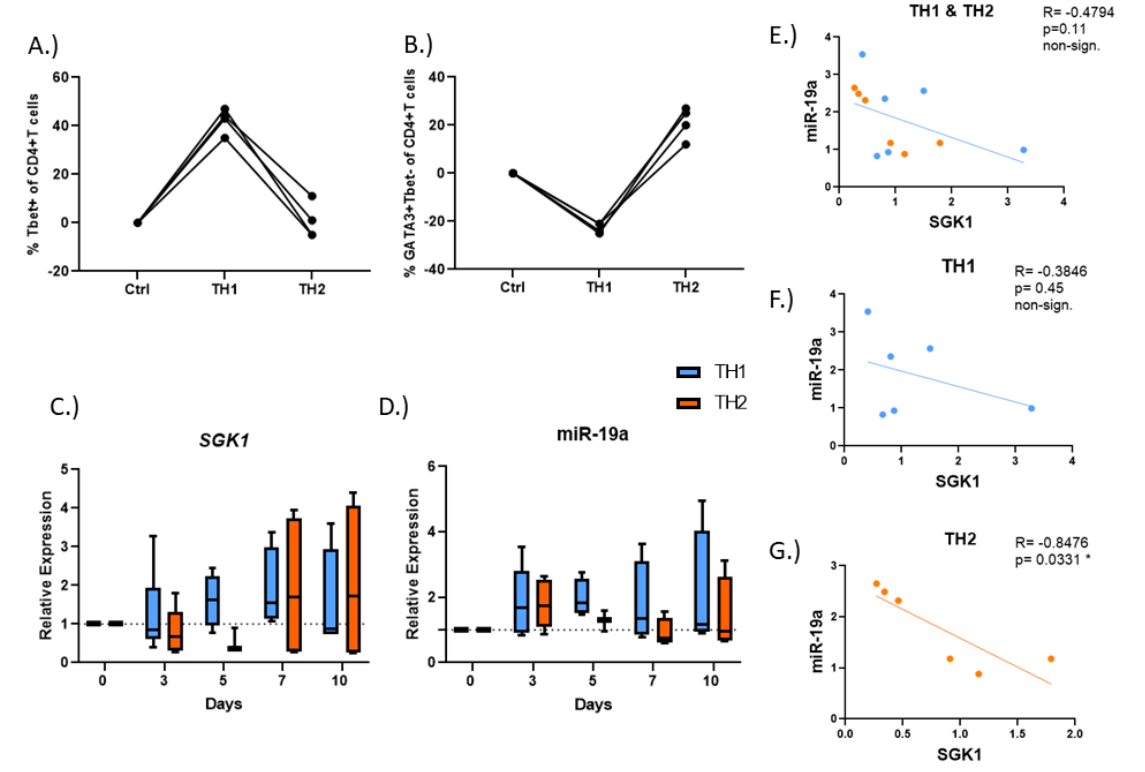
Figure 6. SGK1 and miR-19a play a role in early TH2 cell polarization. CD4+ naïve T cells were isolated from whole blood and subjected to T cell polarizing conditions for up to 10 days. Cells stimulated under TH1 or TH2 conditions were examined after 10 – 12 days by flow cytometry, and T-bet ( A ) or GATA-3 ( B ) positive CD4+ T cells were measured. Expression of SGK1 ( C ) and miR-19a ( D ) were examined on days 0, 3, 5, 7 and 10 while exposed to TH1 or TH2 polarizing conditions. Expression is normalized to SGK1 and miR-19a expression in day 0 cells, and relative expression is shown as 2 − ddCT . ( E ) Correlations of SGK1 and miR-19a in TH1 and TH2 cells combined after 3 days. Correlations of SGK1 and miR-19a in TH1 ( F ) and TH2 ( G ) cells. TH1 (blue)-T helper 1 cells; TH2 (orange)-T helper 2 cells. n = 3 – 6 individuals per timepoint. * = p < 0.05.